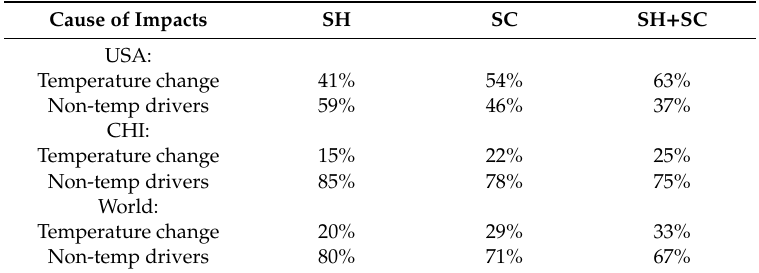
Table 4. Proportions of projected impacts that are due to temperature change at + 3 ◦ C GMST from 2000, and to non-temperature drivers over the same time period.